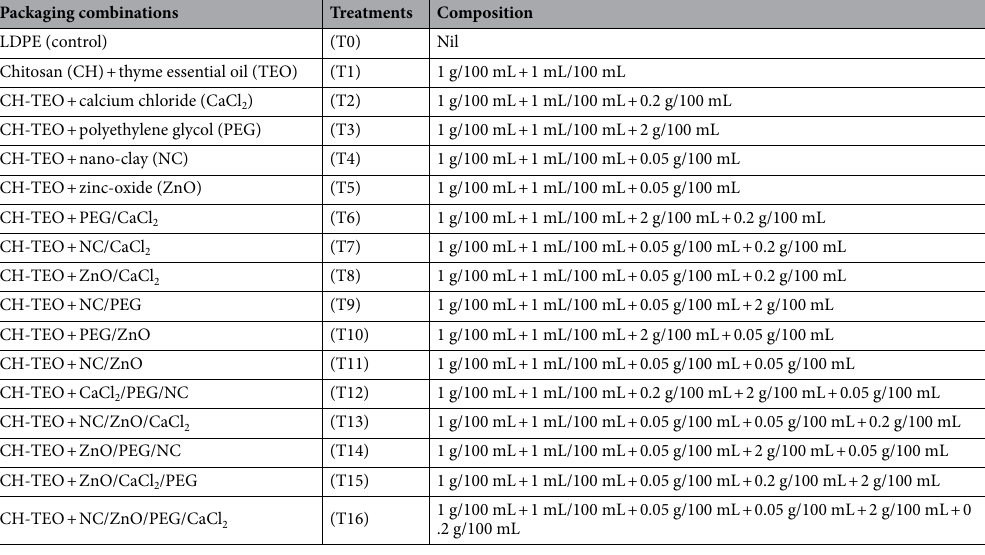
Table 1. Composition of different chitosan-based biodegradable